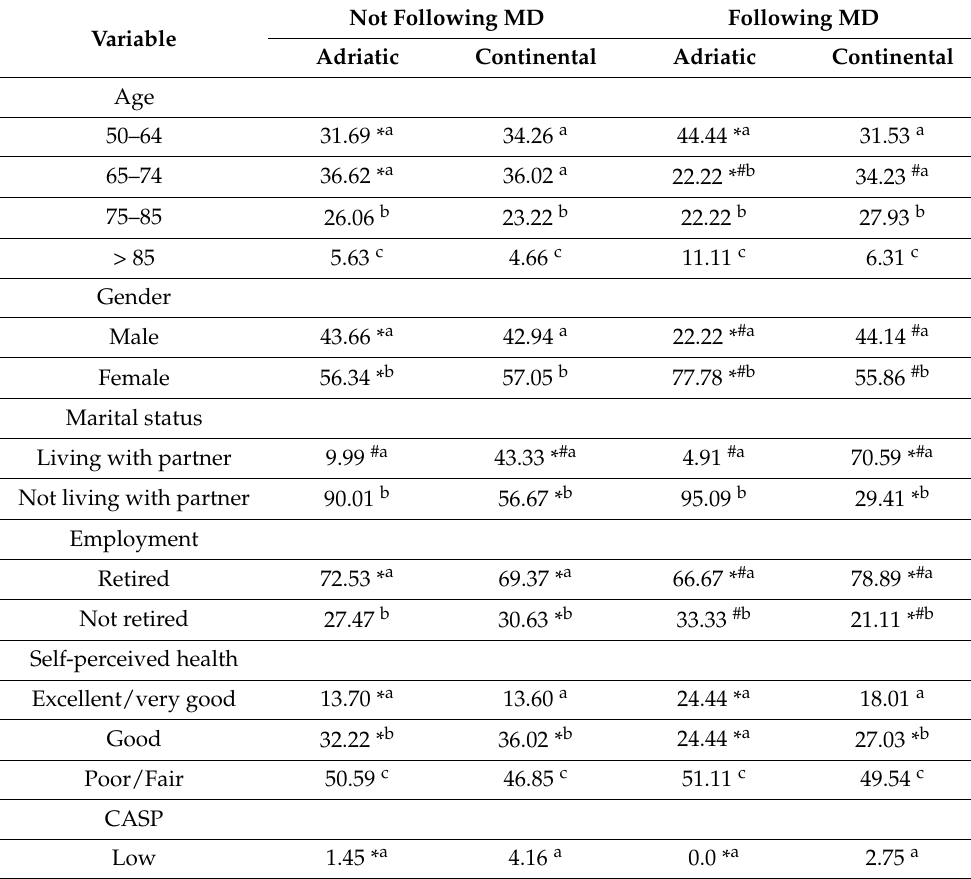
Table 2. Characteristics of the Croatian population (n = 1197) due to following or not following the Mediterranean diet in two NUTS regions (Adriatic ( n = 297) and Continental ( n = 910) Croatia).